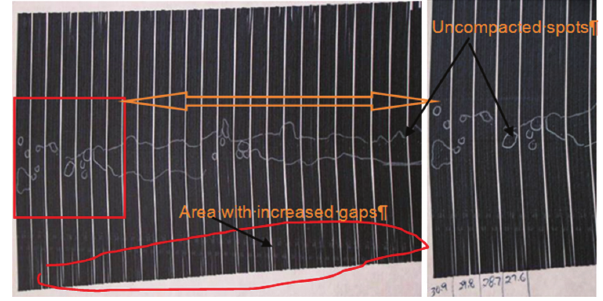
Figure 9 Fiber steering trial case 1: θ = 5 ° , ply 1, laid down at 10.7